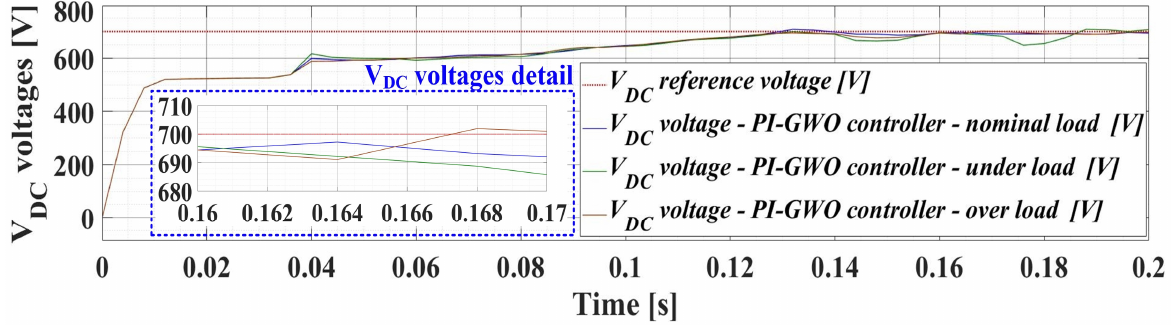
Figure 8. V DC voltages time evolution of the UPQC-APF control system based on PI controller in case of nonlinear load.